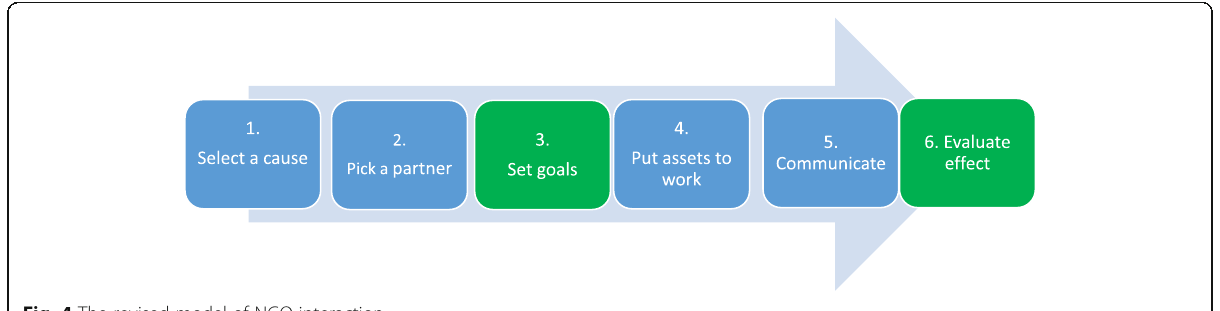
Fig. 4 The revised model of NGO